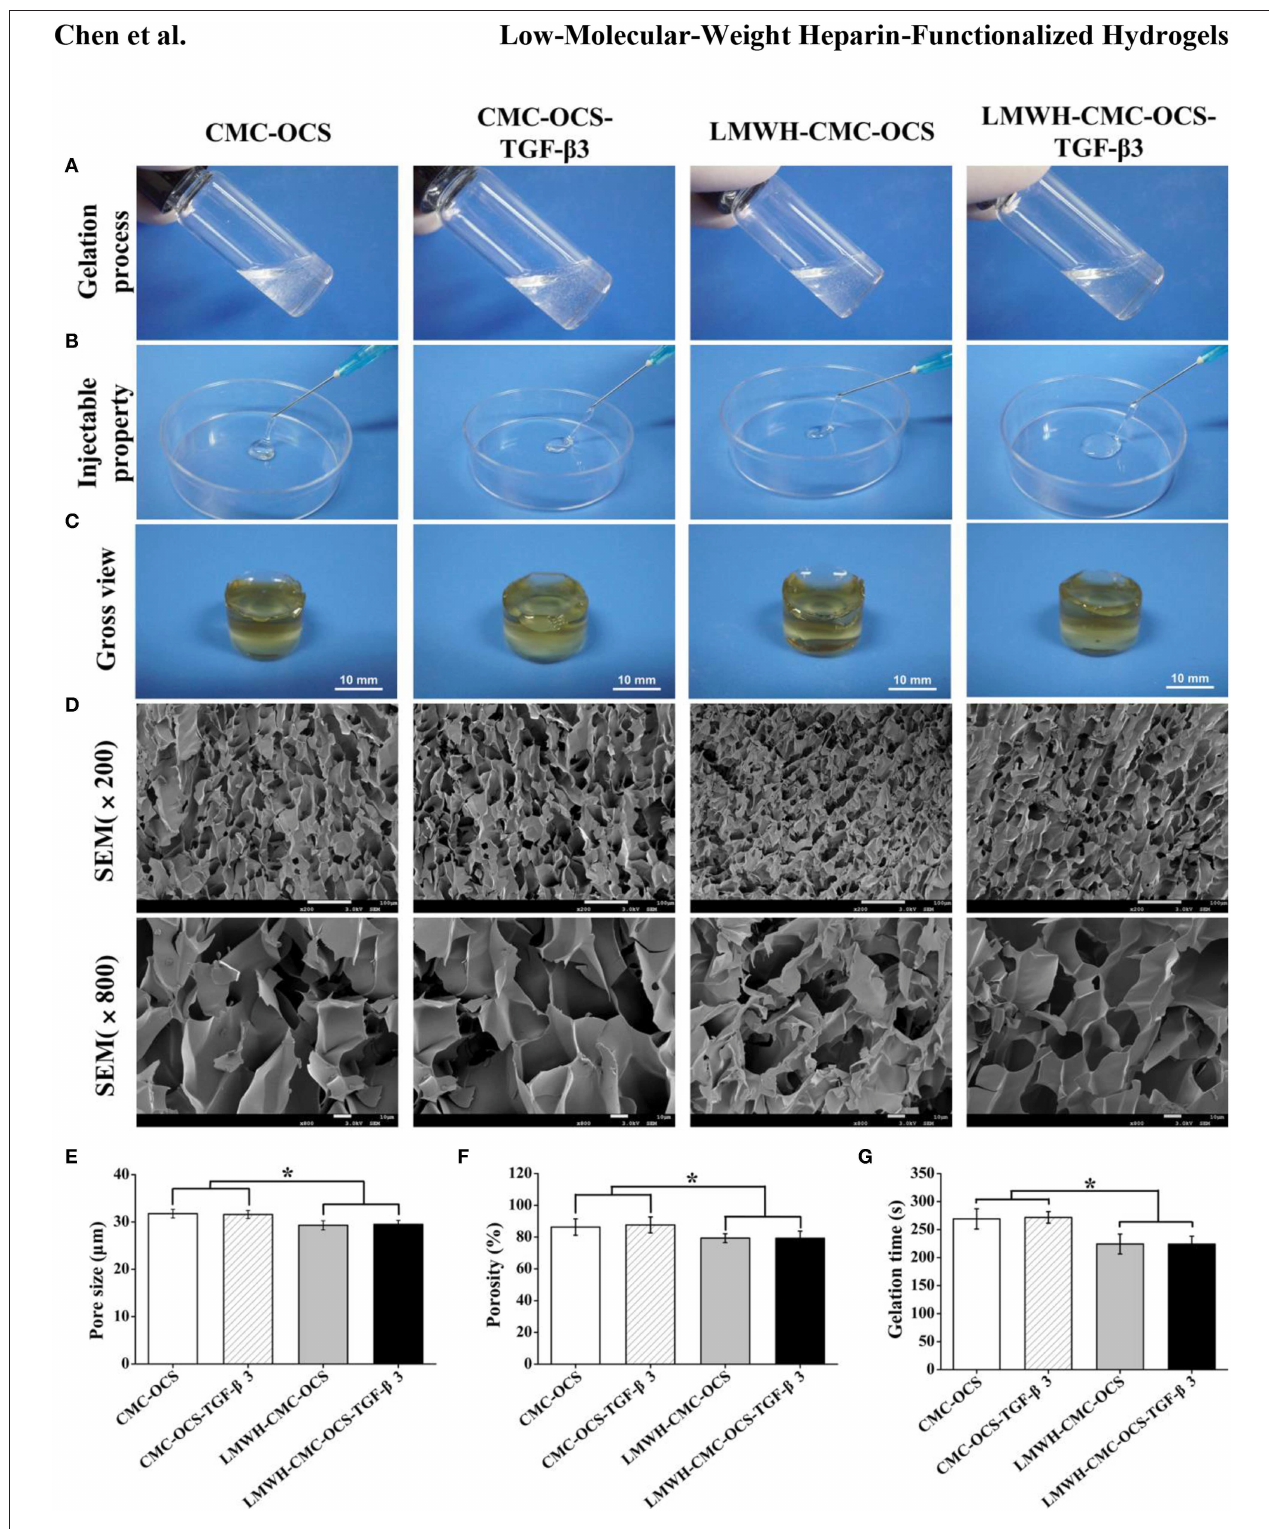
FIGURE 4 | (A) Morphologies of hydrogels before gelation. (B) The extrusion of four hydrogels from medical syringes to show injectable properties. (C) Photographs of gross view. (D) Scanning electron micrographs of hydrogels illustrating the porous and interconnected microstructure. (E) The average pore sizes of four hydrogels ( n = 3, * P < 0.05). (F) The porosities of four hydrogels ( n = 5, * P < 0.05). (G) Gelation time of four hydrogels ( n = 5, * P < 0.05).